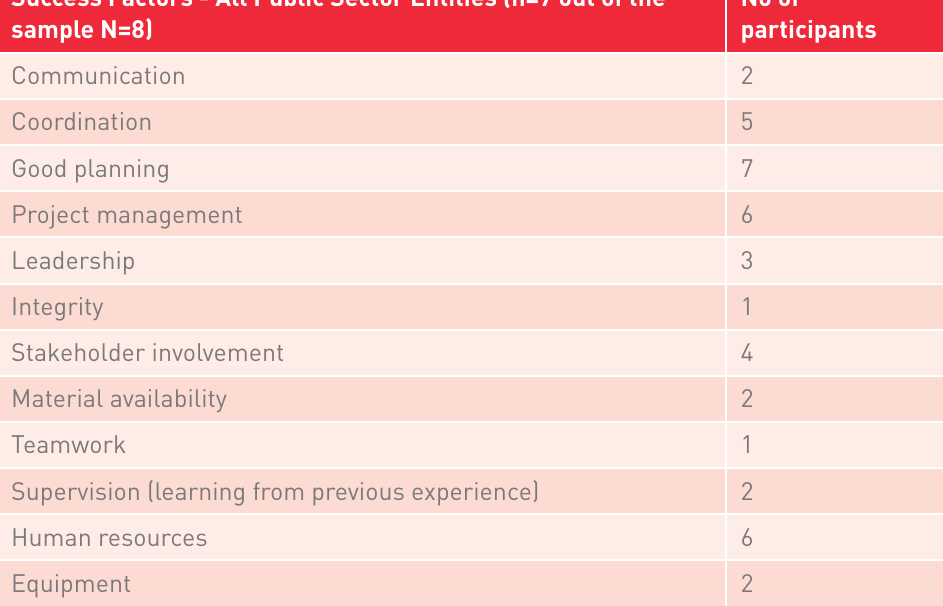
Critical Success Factors from the interviews (All Public Sector Entities) Success Factors - All Public Sector Entities (n=7 out of the sample